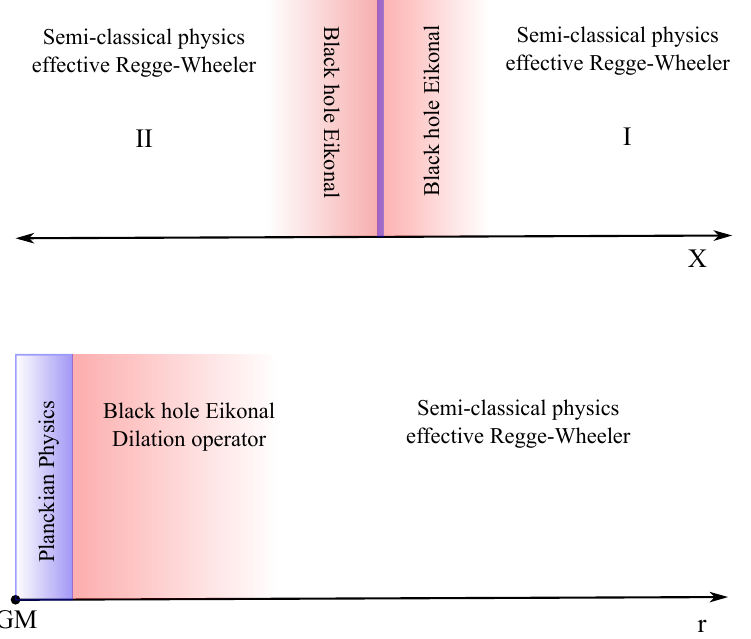
Figure 1 . Propagating fields far from the horizon evolve semi-classically in a fixed background and the physics is largely governed by the effective Regge-Wheeler potential. In the near horizon region ‘ P (cid:28) r − 2 GM (cid:28) GM , the Regge-Wheeler potential vanishes. The dominant effect is that of gravitational interactions governed by the black hole eikonal phase. The in and out modes are related via the scattering kernel (2.5) and they must be matched with the modes near the Regge- Wheeler potential for continuity. An antipodal identification in the effective theory was proposed by ’t Hooft to go from the two-sided black hole to the single-sided one. It is also possible to define a quantum generalisation of it that is consistent with the commutation relations (E.3). This has the added advantage that the spectrum of microstates is now chaotic. Since the spectral spacing is extremely dense, we shall not consider the effects of such a discretisation in the present